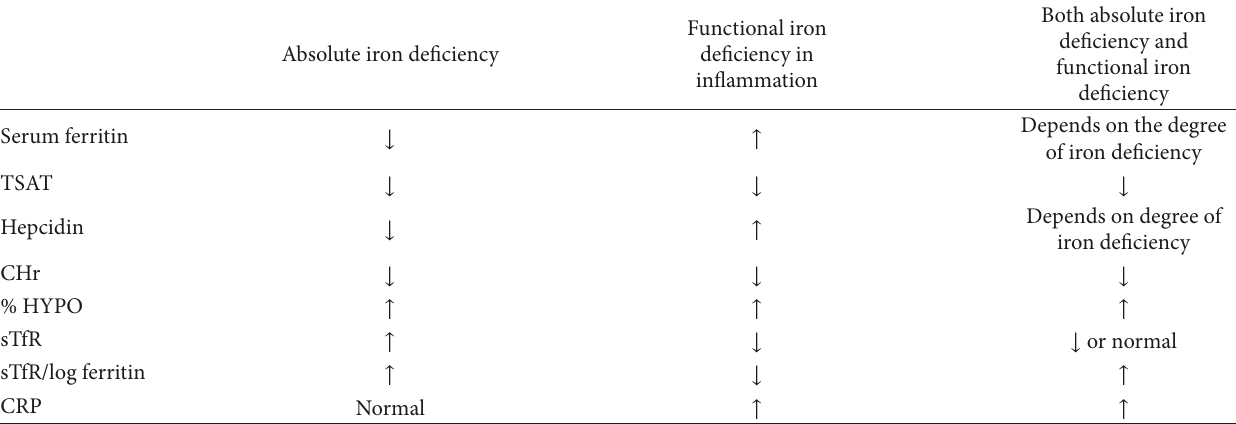
Table 3: Laboratory tests for iron deficiency [4, 32, 50,